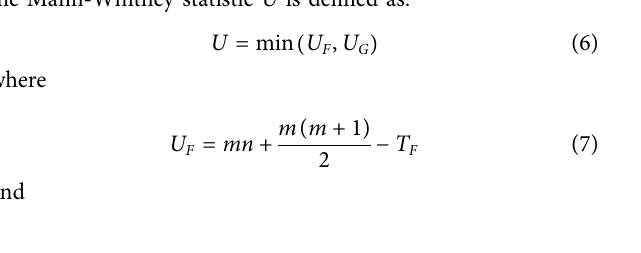
Frontiers in Earth Science |